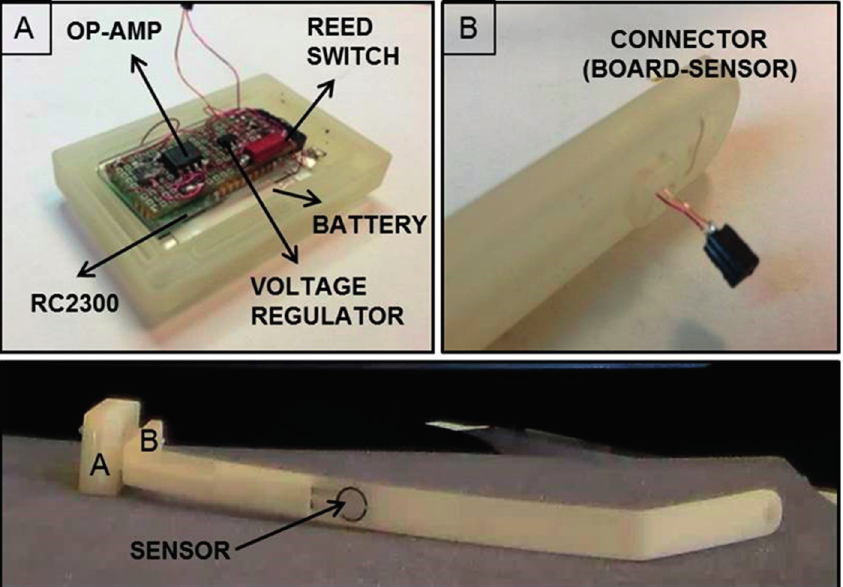
Figure 6. ( A ): RC2300, battery and conditioning circuit in rectangular-shaped rigid protective package. The figure shows the custom conditioning-circuit board. The electrical circuit conditioning is composed mainly of an operational amplifier in non-inverting configuration; ( B ): The connector between the sensor and the electronics. Bottom: Entire implant